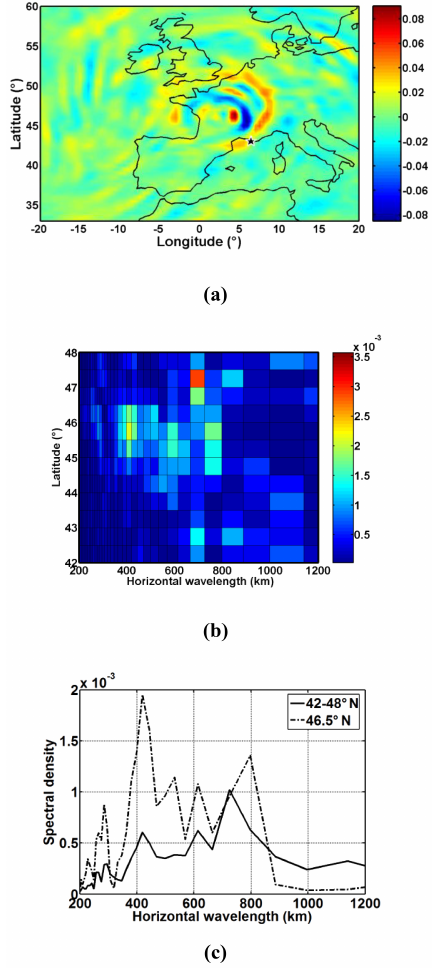
Figure 5. (a) Vertical velocity (Pas − 1 ) at 50hPa in the lower stratosphere derived from ECMWF analyses on 27 July 2013 at 18:00UTC. The star symbol locates Ile du Levant. Colour scale: blue relatively negative high values, red relatively positive high val- ues. (b) spectral density distribution (Pa 2 s − 2 km − 1 ) at latitudes ranged between 42 and 48 ◦ N. Colour scale: red relatively high val- ues, blue relatively low values. (c) spectral density at the latitudes of 42–48 and 46 ◦ N.